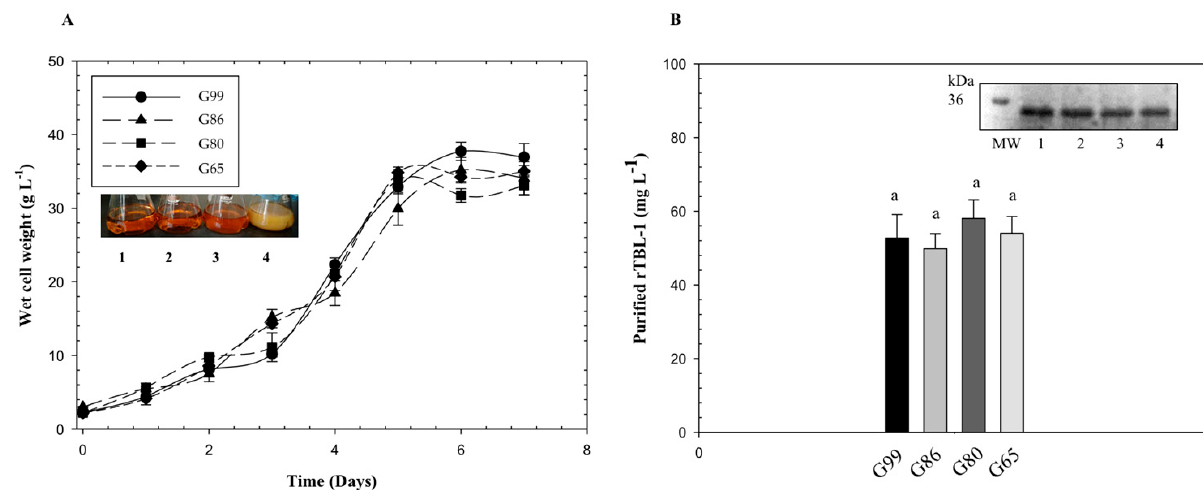
Figure 2. Growth curves and rTBL-1 production using different purity levels of glycerol with P. pastoris yeast. ( A ) Growth of Pichia pastoris for different sources of glycerol; ( B ) rTBL-1 production and purification. SDS-PAGE: lane 1, G99; lane 2, G86; lane 3, G80; lane 4, G65. M, molecular weight marker. Erlenmeyer flask level, 30 ◦ C, 200 rpm. Glycerol initial concentration was 40 g L − 1 . Same letters represent no significant differences between treatments ( p ≤ 0.05; Tukey, SAS System Version 9).